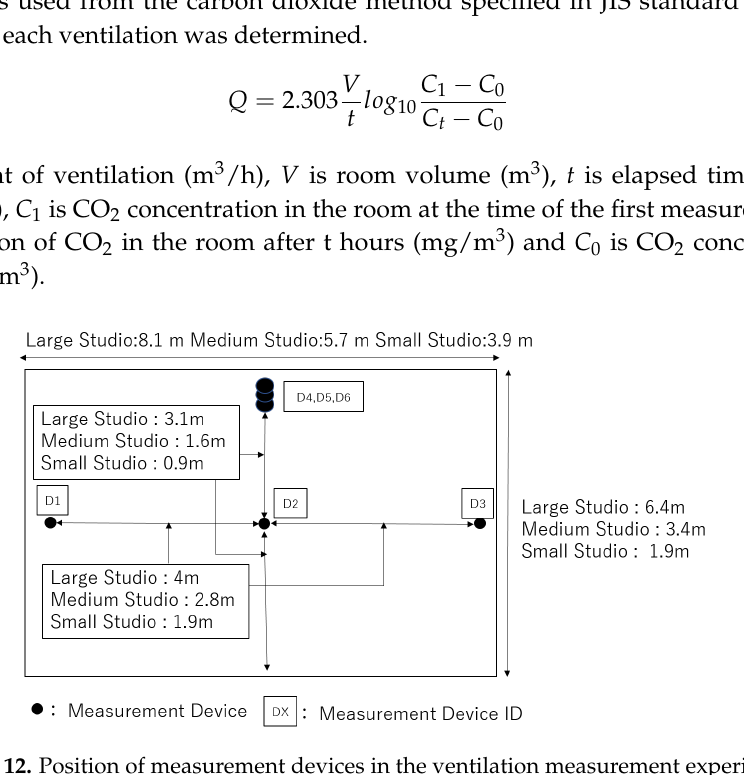
Figure 12. Position of measurement devices in the ventilation measurement